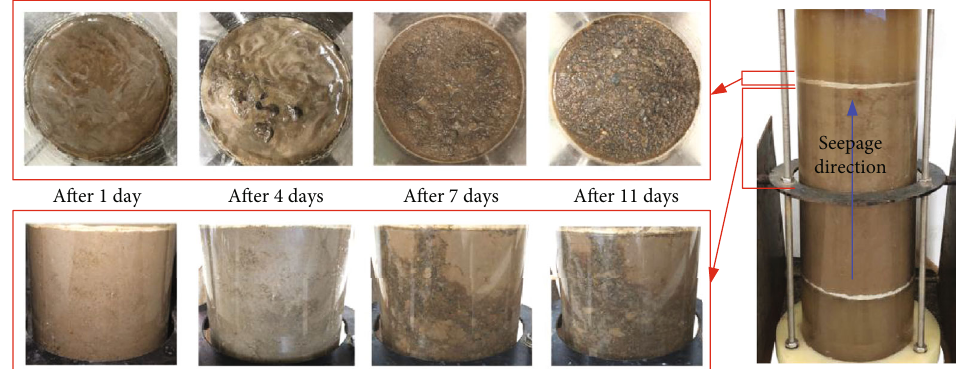
Figure 10: Progression of seepage erosion of the soil samples during the permeability test.